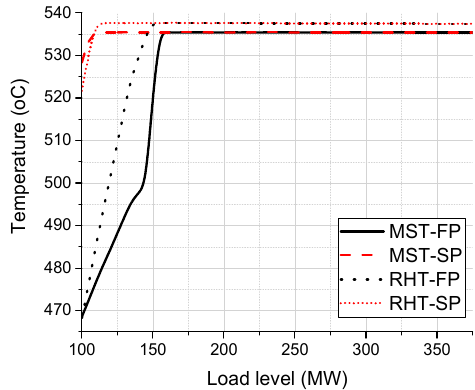
Figure 5. Main Steam Temperature (MST) and Reheater Temperature (RHT) as a function of load level in FP and SP operation modes. in FP and SP operation